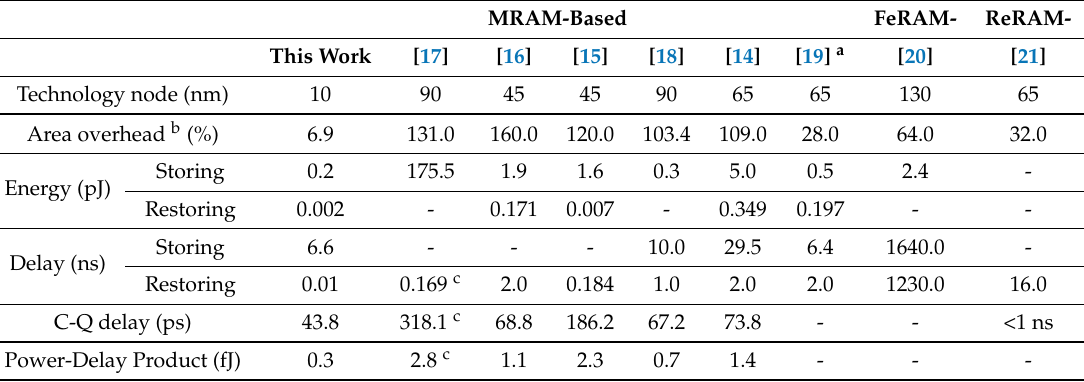
Table 2. Performance summary and comparison with the state-of-the-art NVFFs. MRAM-Based